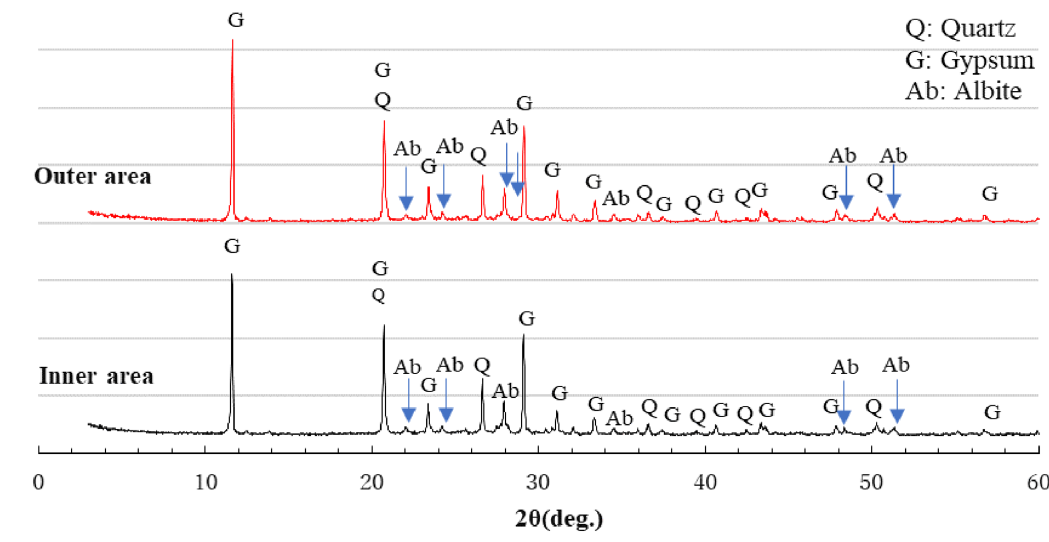
Figure 13. XRD patterns of series BFSCSP after sulfuric acid immersion.